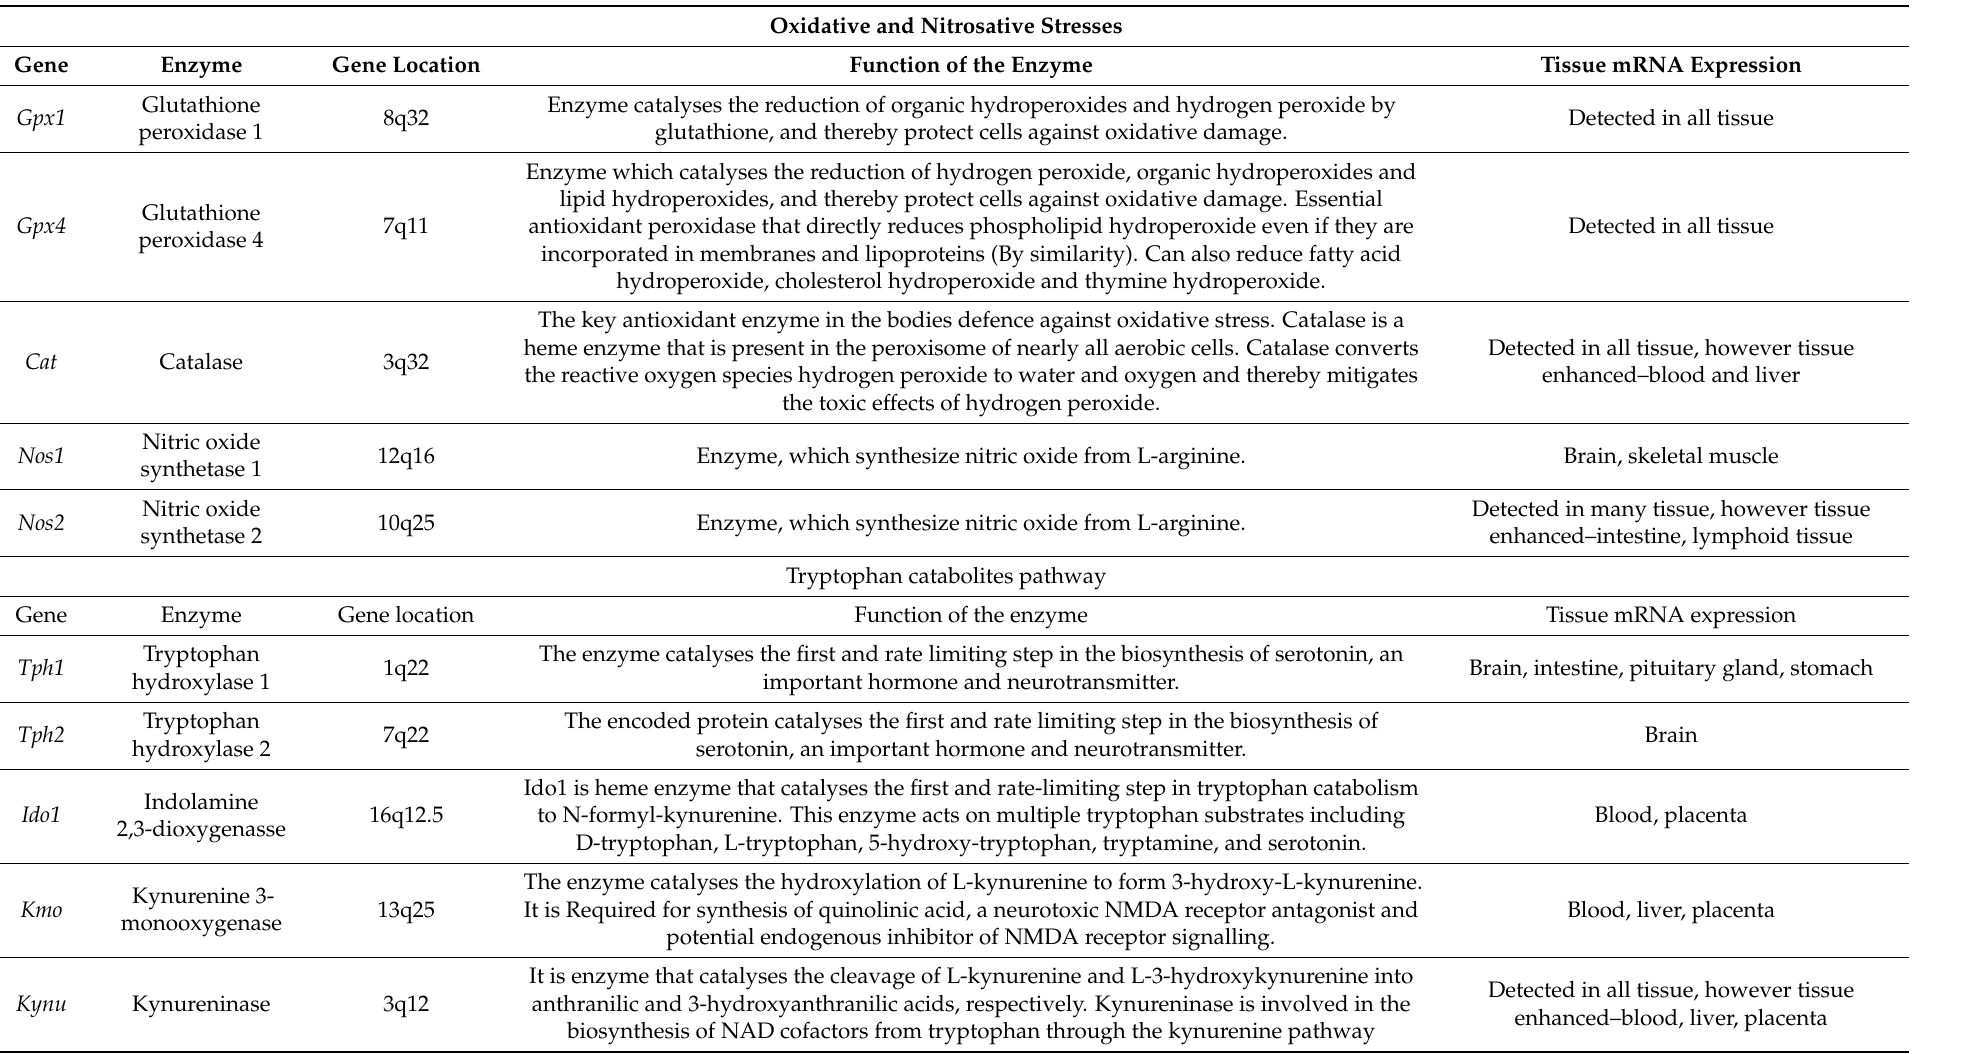
Table 1. Characteristic of all studied genes in the presented